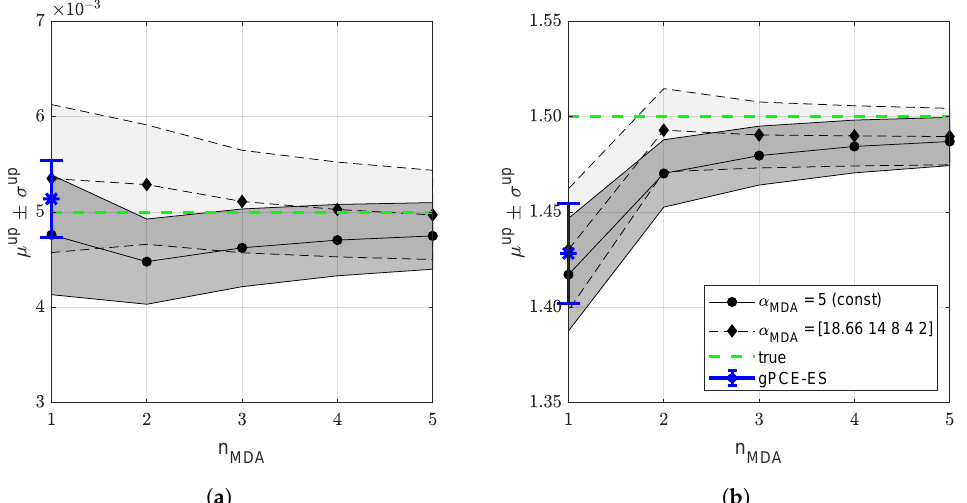
Figure 8. Mean and standard deviation of the updated ensembles obtained with gPCE-MDA in case of constant and decreasing α MDA for parameter ( a ) λ ∗ and ( b ) R considering the “true” parameter set p t = ( 0.005,1.5 ) . The blue bar refers to the results obtained with the gPCE-ES